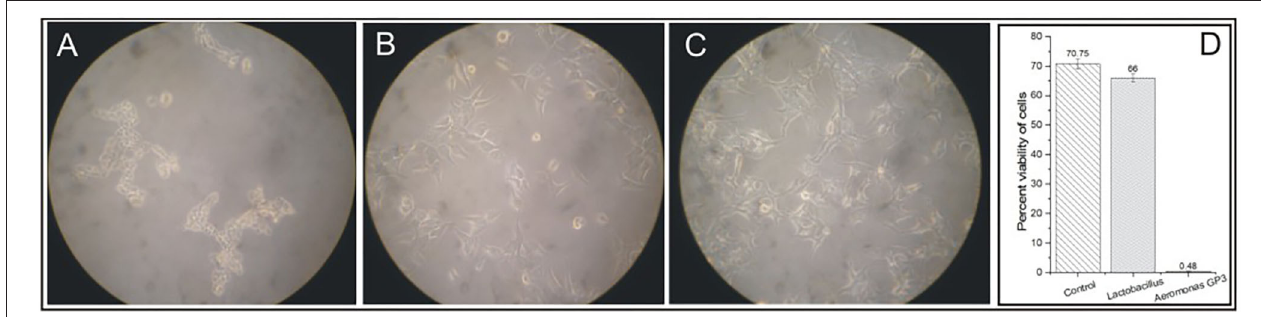
FIGURE 2 | Cytotoxicity of isolated Aeromonas strain GP3 in WRL-68 cell line. (A) Treated with culture filtrate of GP3 showing visible rounding off and detachment of monolayers. (B) Treated with cell-free filtrate of Lactobacillus sp. showing minor morphological changes. (C) Control (treated with sterile LB medium) showing no change in cell morphology. (D) Graph representing the cell viability